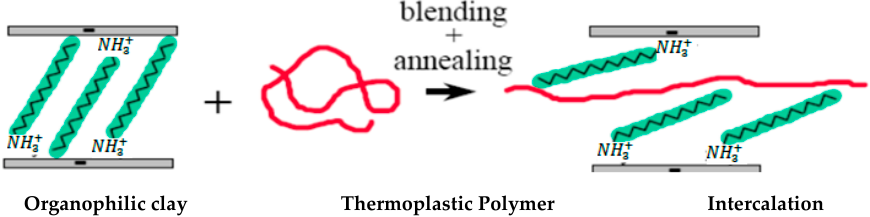
Figure 7. Melt blending technique for the preparation of polymer/clay nanocomposites.